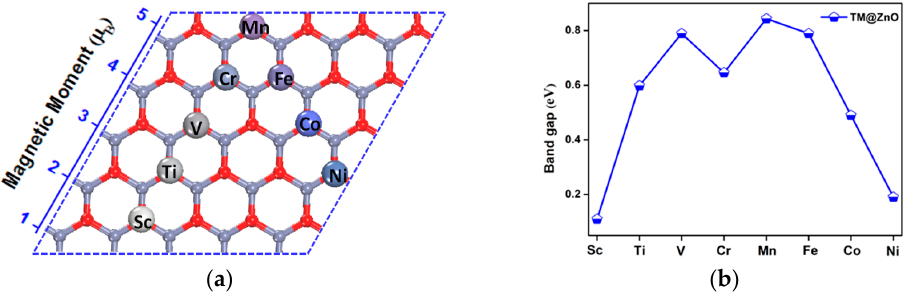
Figure 3. Magnetic moments and bandgap of transition metal (TM) adsorbed on the ZnO monolayer complex. ( a ) The most stable adsorption sites and total magnetic moment of the TM-adsorbed complex; ( b ) Bandgap of the complex.